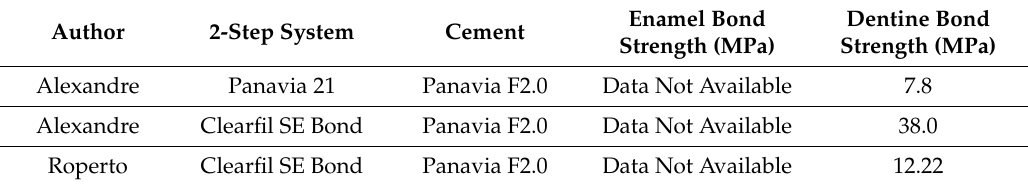
Table 5. Bond strength of 2-step self-etch adhesive systems.